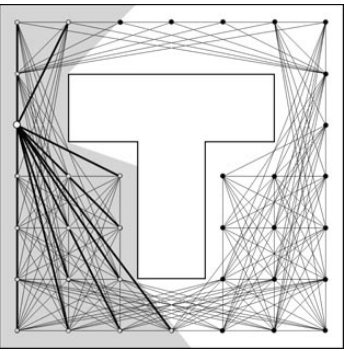
Figure 7. An example of a first-order visibility graph, showing the pattern of connections for a simple configuration (Turner et al.,